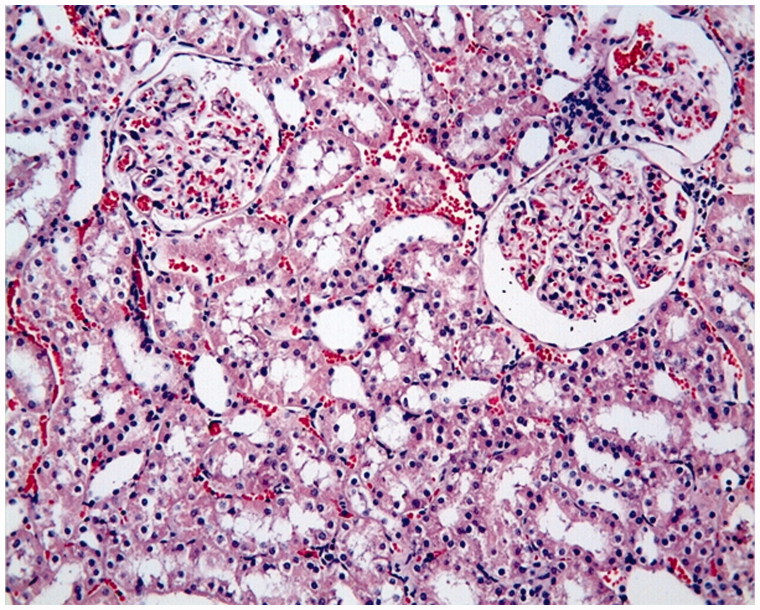
Control group: proximal tubules, distal tubules and glomerular structures are observed in normal histological state, H–E; ×20.